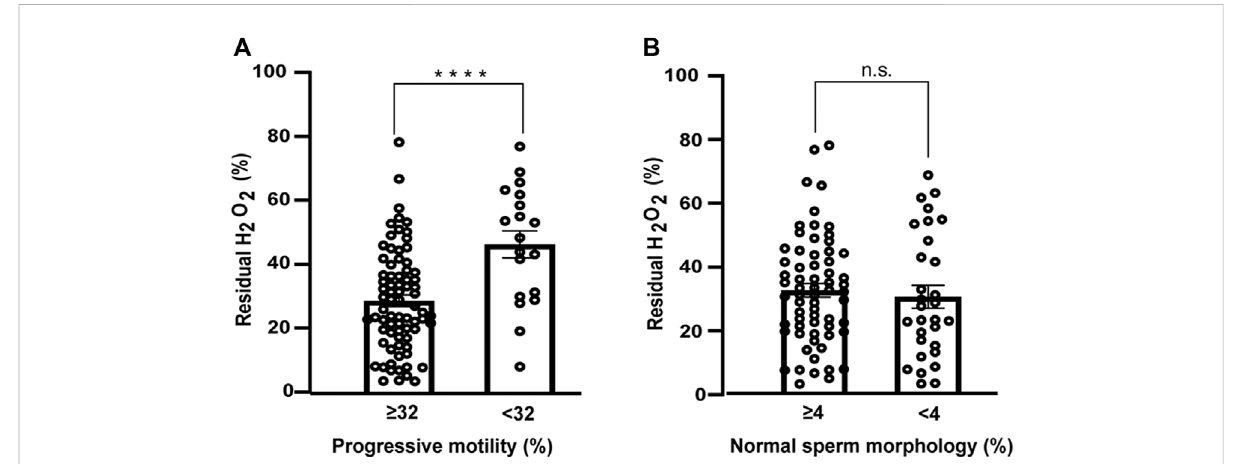
FIGURE 4 Antioxidantcapacityofseminalplasmaasafunctionofspermparameters. (A) Progressivemotility( ≥ 32% N =76; < 32% N =19) (B) normalsperm morphology( ≥ 4% N =65; < 4% N =30).BarsrepresentthepercentageofresidualH 2 O 2 after30min±SEM.Mann-Whitneytestwasusedtodetermine statistical signi fi cance n.s. P > 0.05, **** p < 0.0001.